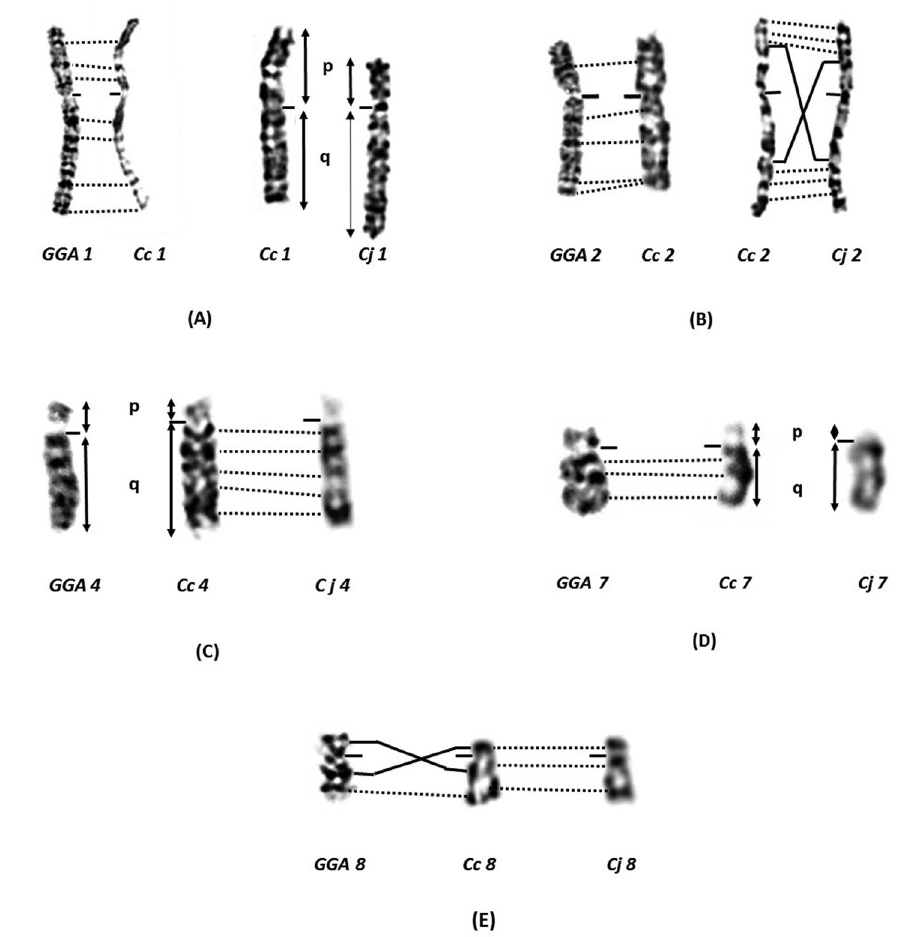
Figure 7. Comparison of chromosomes 1 A 2 B 4 C 7 D and 8 E of domestic chicken GGA (left), Com- mon quail Cc (in the middle) and Japanese quail Cj (right) with the GTG